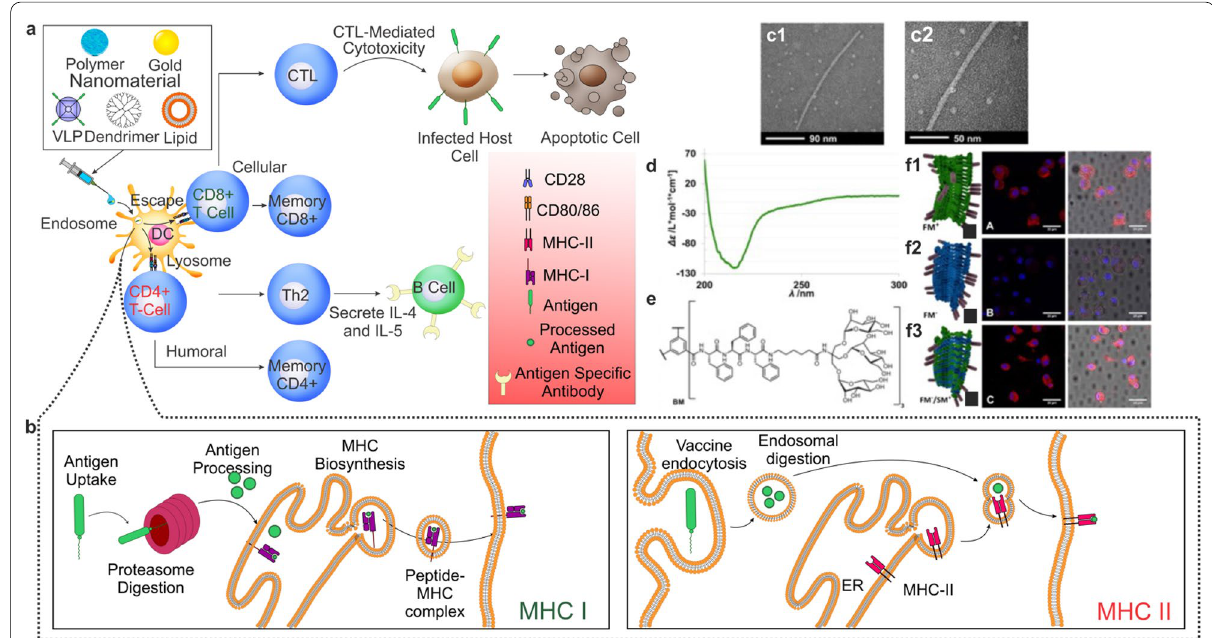
Fig. 7 Bacterial vaccine and antigen‑presenting pathways. a Various nanoparticles that are used to deliver antigens or antigen fragments for bacterial vaccines. Following the delivery of these antigen‑bound/encapsulated platforms, the cell uptakes the vaccine via endosomal pathways. From here, the antigen can undergo processing in either the endosome, via the MHC‑II pathway, or be processed by proteases in the cytoplasm before the presentation by the MHC‑I complex. Antigen presentation via MHC‑II results in humoral immunity where T h 2 cells activate B cells to produce antibodies against the bacteria. Conversely, MHC‑I presentation results in the differentiation of T cells into CTLs that can initiate cell death by cellular immunity. b Pathways for MHC‑I and MHC‑II antigen processing. In MHC‑I presentation, the antigen can escape the endosome and is processed by proteases. The processed antigen is transported to the endoplasmic reticulum (ER), where MHC biosynthesis occurs, complexes with the MHC‑I ligand, and is transported to the cell membrane for presentation to T cells. During MHC‑II pathways, the antigen is digested in the endosome and fuses with MHC‑II intracellularly to form the peptide MHC‑II complex prior to being shuttled to the cell surface for presentation. c TEM characterization of negatively stained self‑assembly polymer to demonstrate monodispersity and size range of mannose‑decorated multicomponent supramolecular polymers targeted towards APCs. d Circular dichroism spectra of dendritic glycopeptide peptide. e Chemical structure of amphiphilic glycopeptide used as a monomer for self‑assembly. f Cellular uptake of self‑assembled polymers with and without mannosylated monomers ( f1 and f2 ) and mannosylated monomers without a fluorescent label ( f3 ). Reproduced with permission from ref